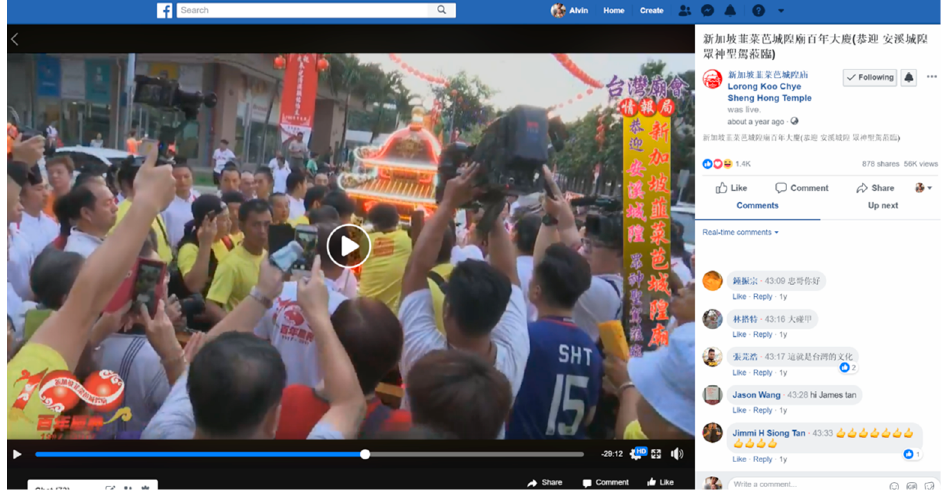
Figure 4. Cheng Huang Ye’s Palanquin Arrives Outside Sheng Hong Temple. Source: Facebook.